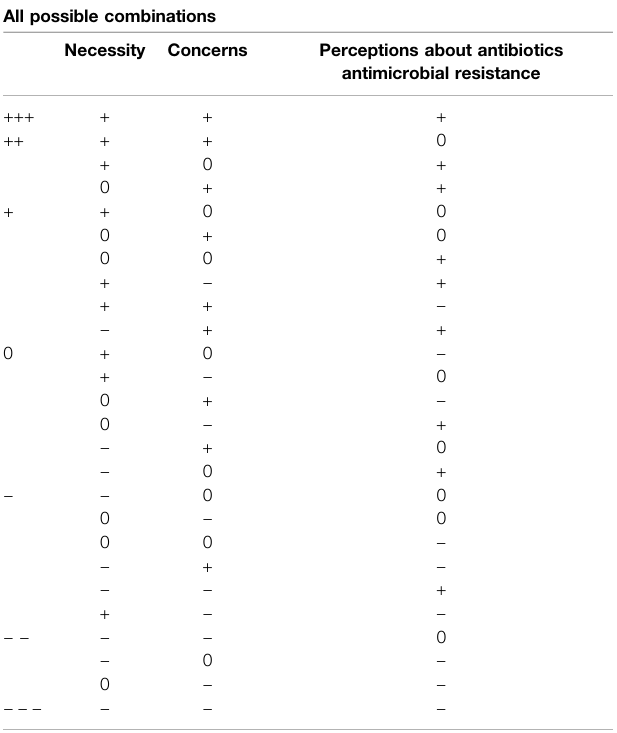
TABLE 1 | Different possible combinations of effectiveness for each subscale and corresponding coding of aggregate impact which considers overall